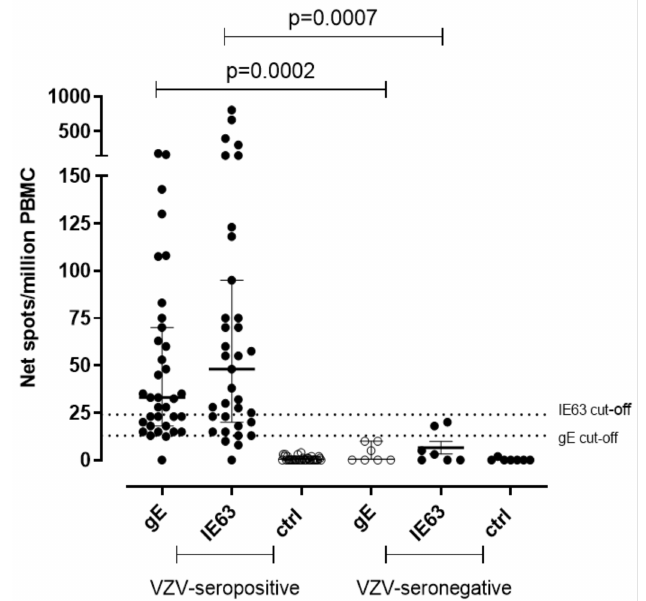
Figure 1. Ex vivo ELISpot assay for VZV-specific T-cell response. VZV-specific T-cell response to gE and IE63 35 VZV-seropositive healthy subjects and 7 VZV-seronegative healthy subjects. The cut-off of positive responses was calculated as the mean of the response in VZV-seronegative subjects plus two standard deviations. Ctrl: Ex vivo ELISpot assay measured against medium only.